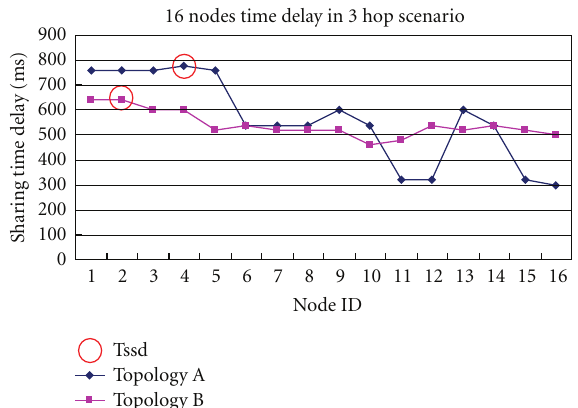
Figure 14: Sharing time delay in 3-hop scenario.